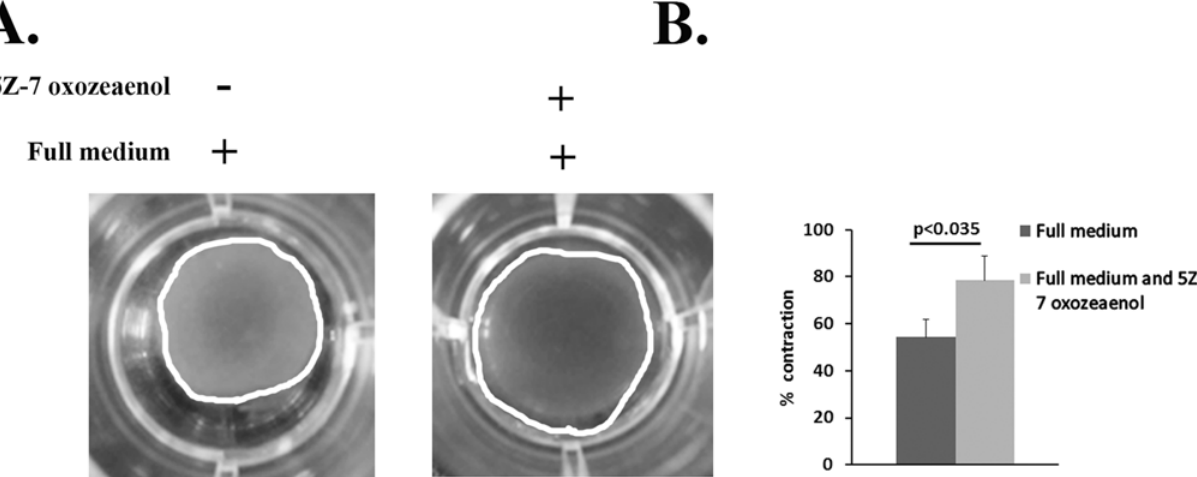
Fig 5. TAK1 is a general regulator of the EMT process in RPE cells. A: RPE cells were pre-treated with or without 5Z-7-oxozeaenol (1 μ M) and seeded in collagen lattices in full medium. The experiments were performed in triplicates. Lattices were photo-documented after 24 hours and measured using Image-J software. B: The histogram demonstrates the percentage of lattice area (marked by white line) relative to initial gel area, based on three independent experiments. Statistics were computed using student t-test (Two tailed distribution equal variance). Data is expressed as the Mean ± SD.